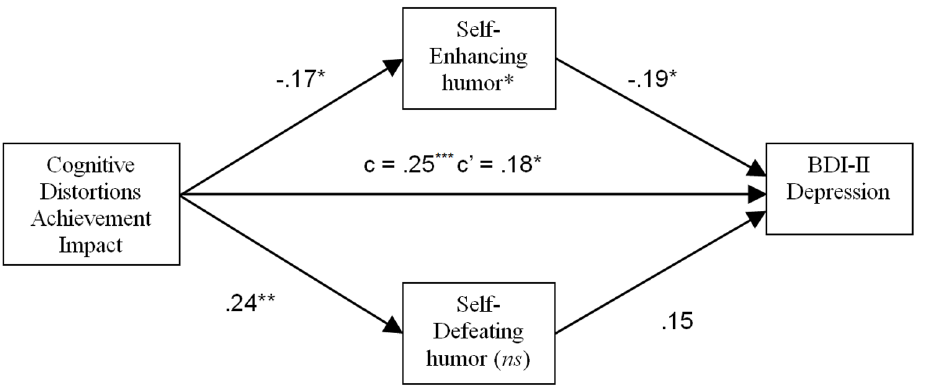
Figure 6. Mediating effect of Self-Enhancing humor on the relation between impact of cognitive distortions in achievement contexts and depressive